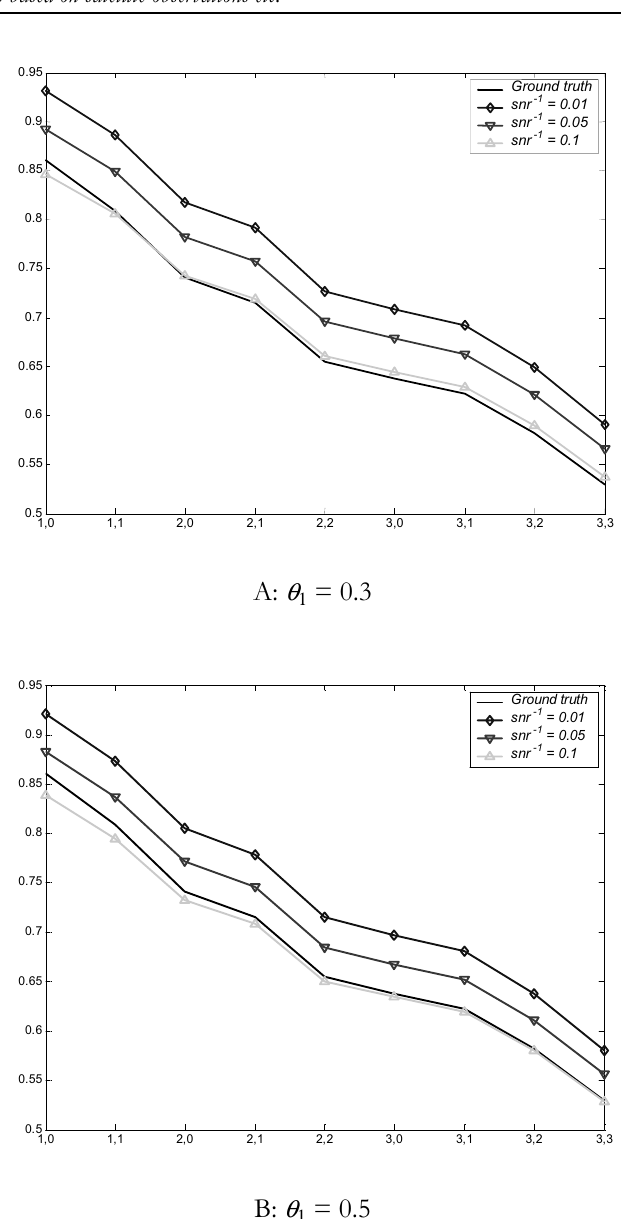
Figure 1 – Spatial correlation distortions in the remotely acquired images for various values of loca- tion and attribute error parameters ( θ and snr ), under model (11), for the strong dependency case 1 ( β = 0.15 in equation (12)). Error-corrupted correlations are reported in the graph for spatial lags = 0.3 (Plot A), and θ = 0.5 (Plot ( k , h ), k , h = 0, ..., 3, when snr -1 =0.01, 0.05, 0.1, θ 1 1